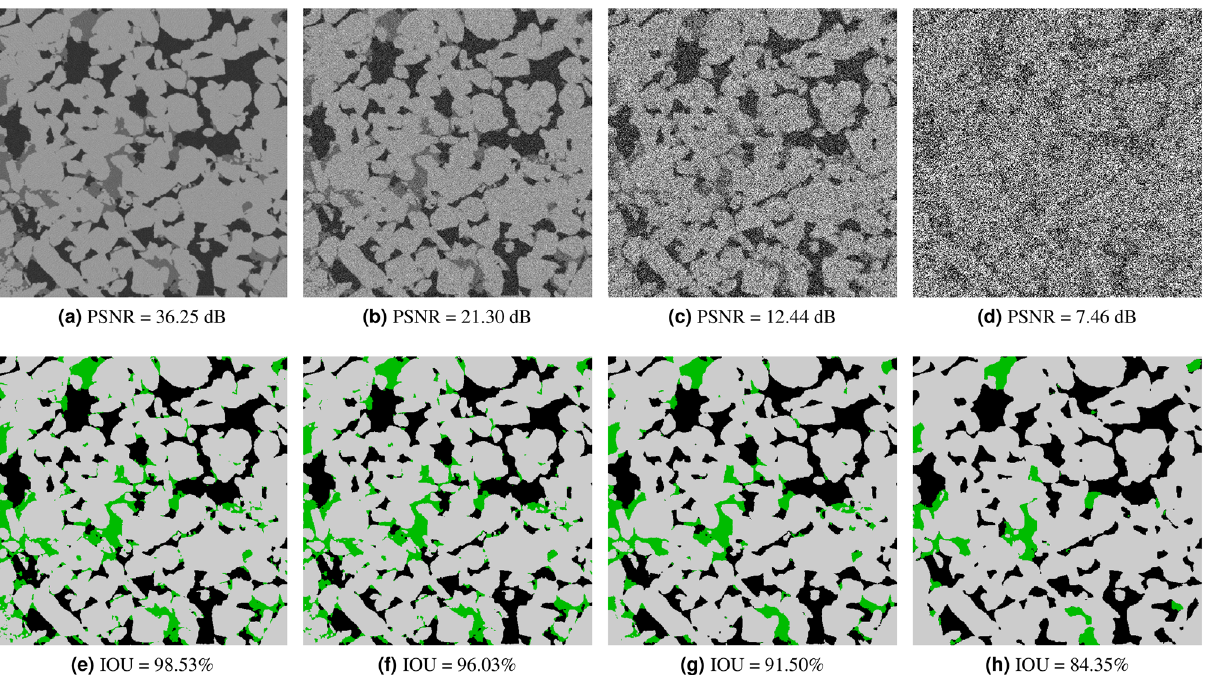
Figure 6. Segmentation results for the reservoir sandstone on synthetic images generated with Gaussian noise pre-projection.